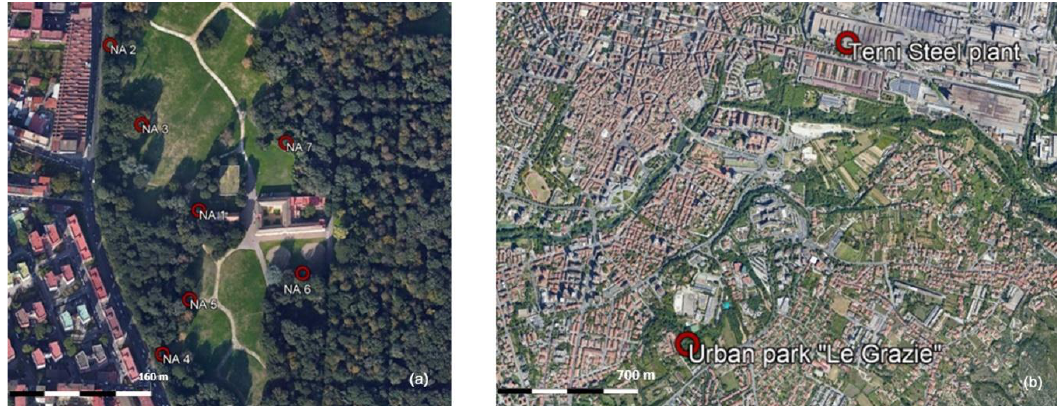
Figure 1. ( a ) Location of the seven sampling sites within the urban forest “Real Bosco di Capodimonte” in Naples (Italy). ( b ) Location of the urban park “Le Grazie” in Terni (Italy), with respect to the main air pollution source (i.e., the steel plant).